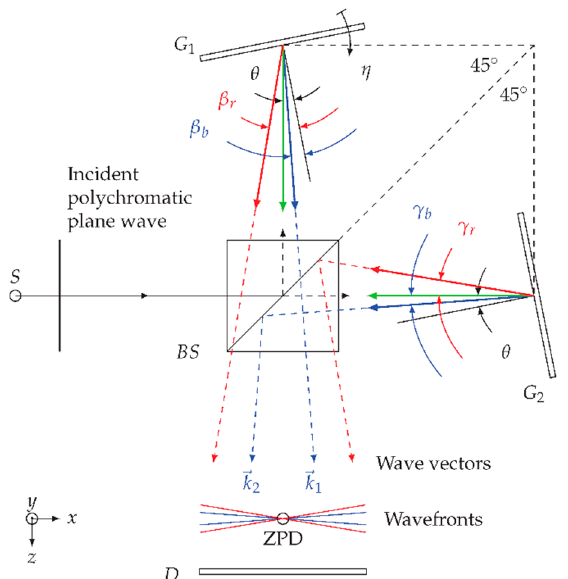
Figure 3. Basic principle of spatial heterodyne spectroscopy (SHS). G 1 and G 2 are fixed and tilted diffraction gratings replacing the mirrors of a Michelson interferometer (figure from [5]; see reference for details). ZPD, zero-path-difference line along axis y .